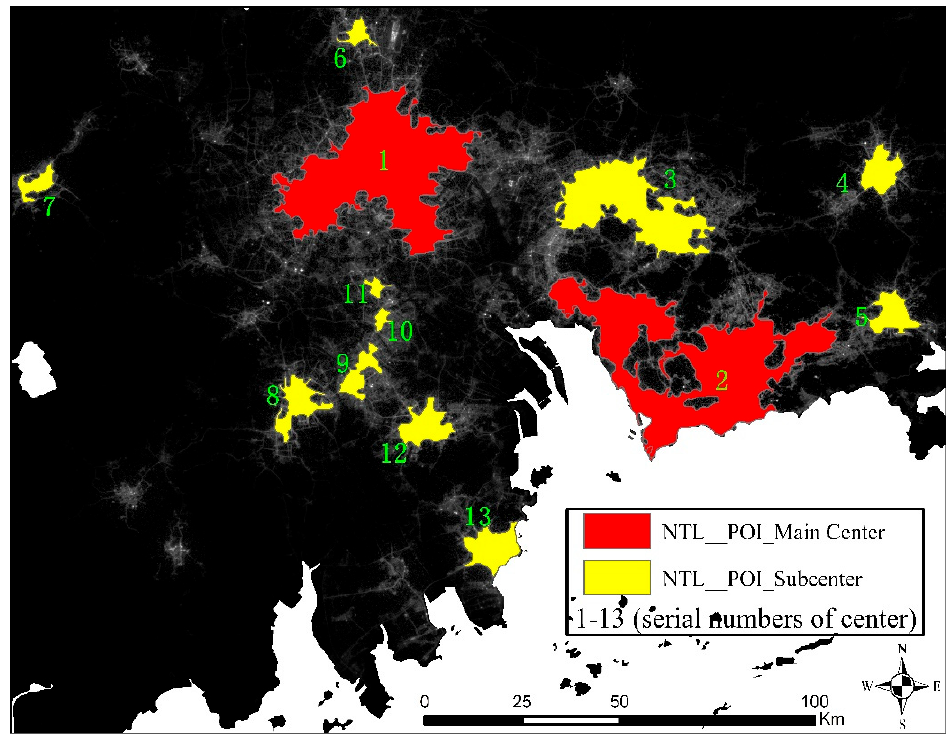
Figure 10. The urban main center and subcenter of PRD, identified by NP.